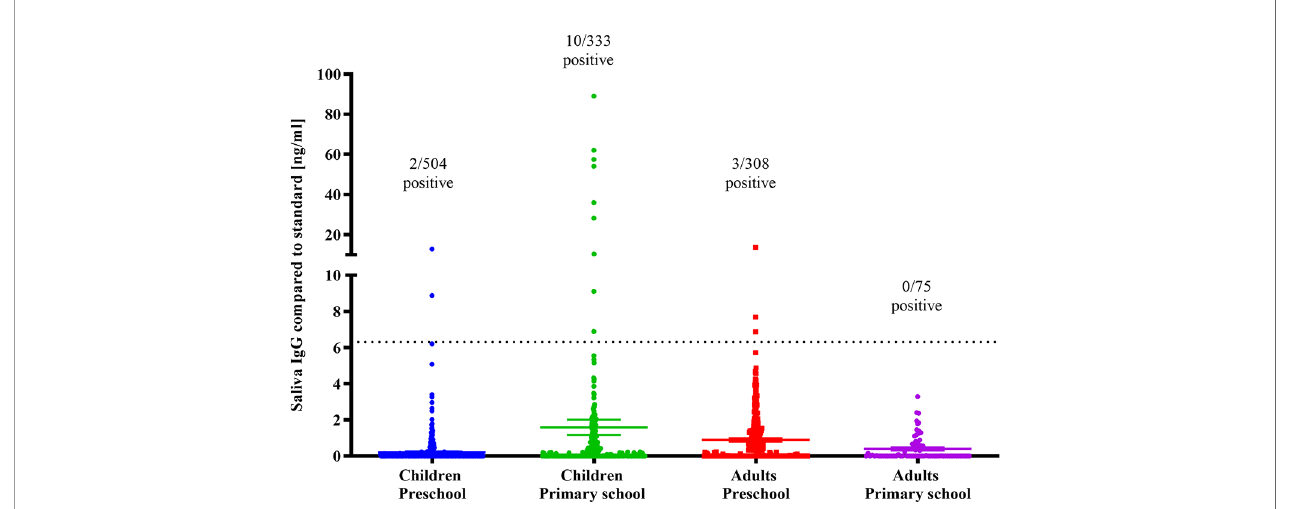
FIGURE 5 | SARS-CoV-2 IgG in saliva of young children and adults. SARS-CoV-2 RBD reactive IgG concentrations in saliva of preschool children and primary school kids and accompanying parents and tutors (adults). Dotted line: Cutoff for SARS-CoV-2 IgG positivity.